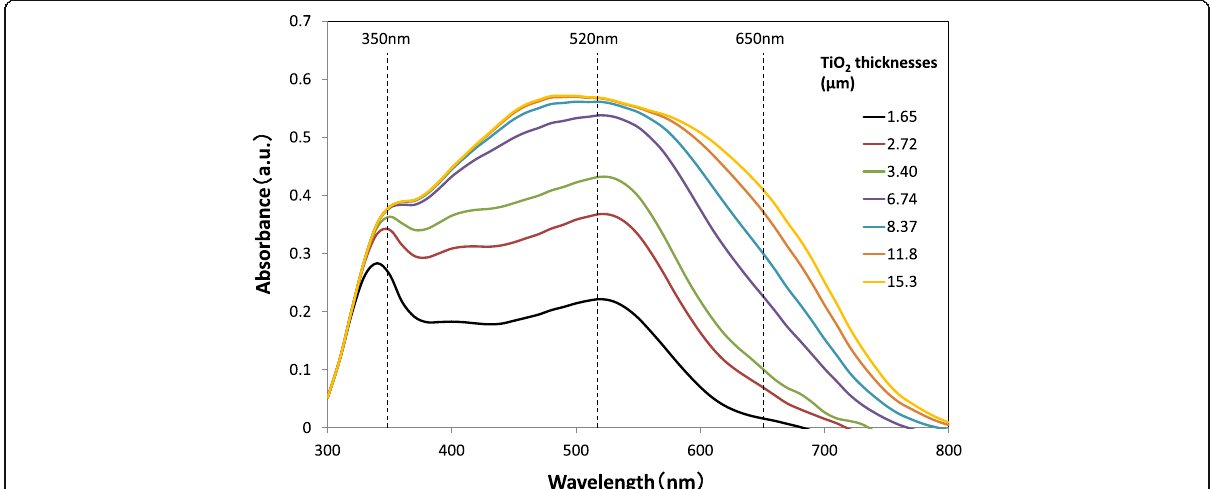
Fig. 12 Absorbance spectra of dyed TiO 2 layers with various thicknesses. The TiO 2 layers do not contain